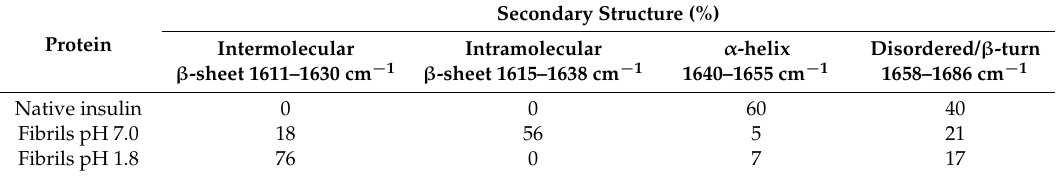
Table 1. Results of amide I’ deconvolution for native insulin and insulin fibrils formed at pH 1.8 and 7.0. Peak spectral ranges (in agreement with [46,48]) and secondary structure subcomponent contributions are